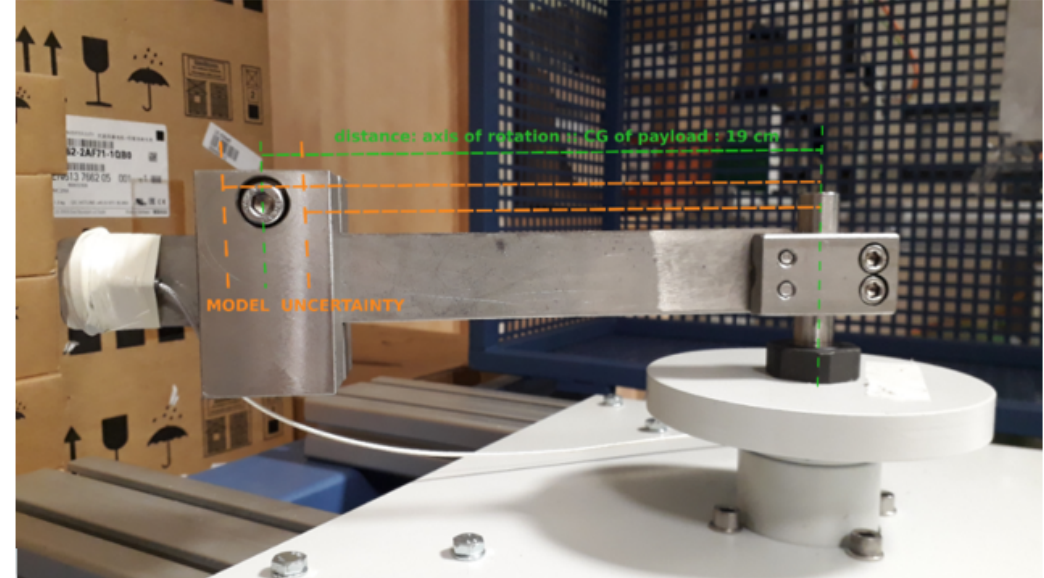
Figure 18. Assumed parametric uncertainty: variable-load mass position emulating varying machine dynamics due to production and assembly tolerances, design variations, or second degree of freedom